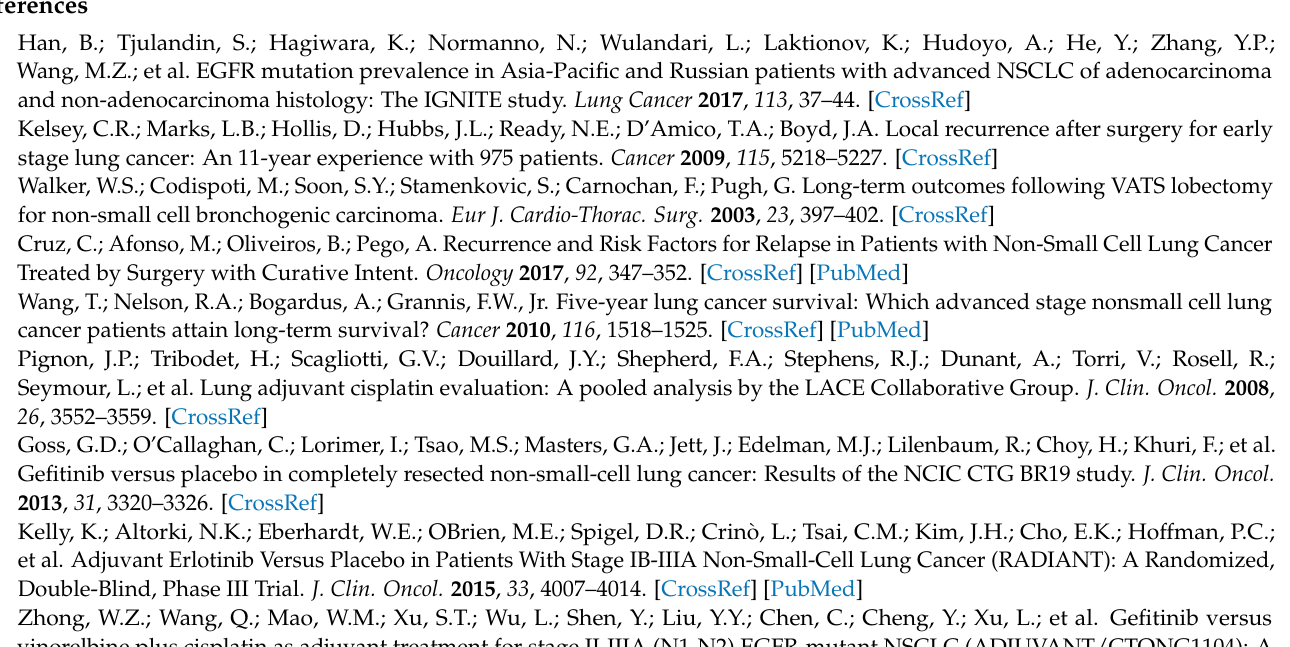
Table S3: Univariable and multivariable analyses of prognostic factors on survivals (2015~present). Author Contributions: Conceptualization, H.L. (Hui Liu) and Q.L.; methodology, Q.L. and